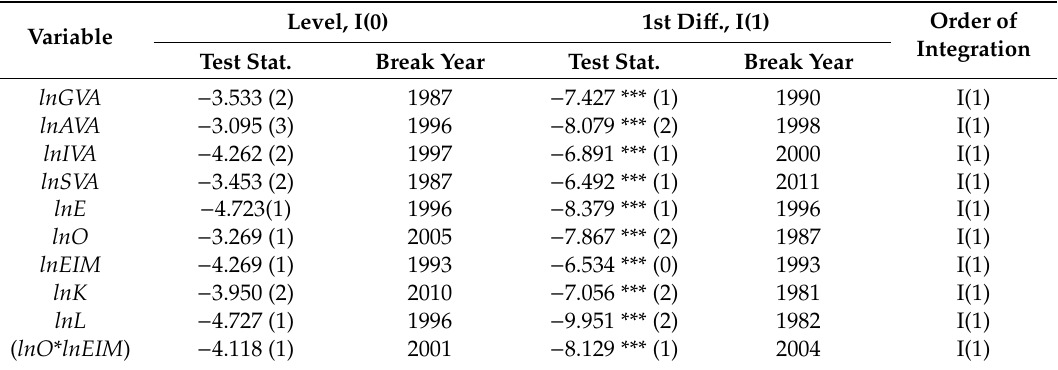
Table 3. The Zivot-Andrews unit root test